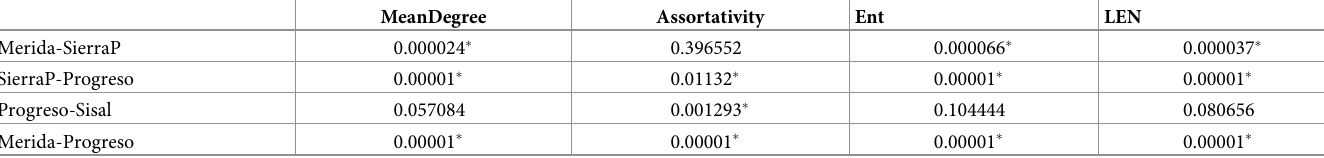
Table 4. P-values of t-tests performed for neighboring cities for each metric in the networks presented in Table 3.